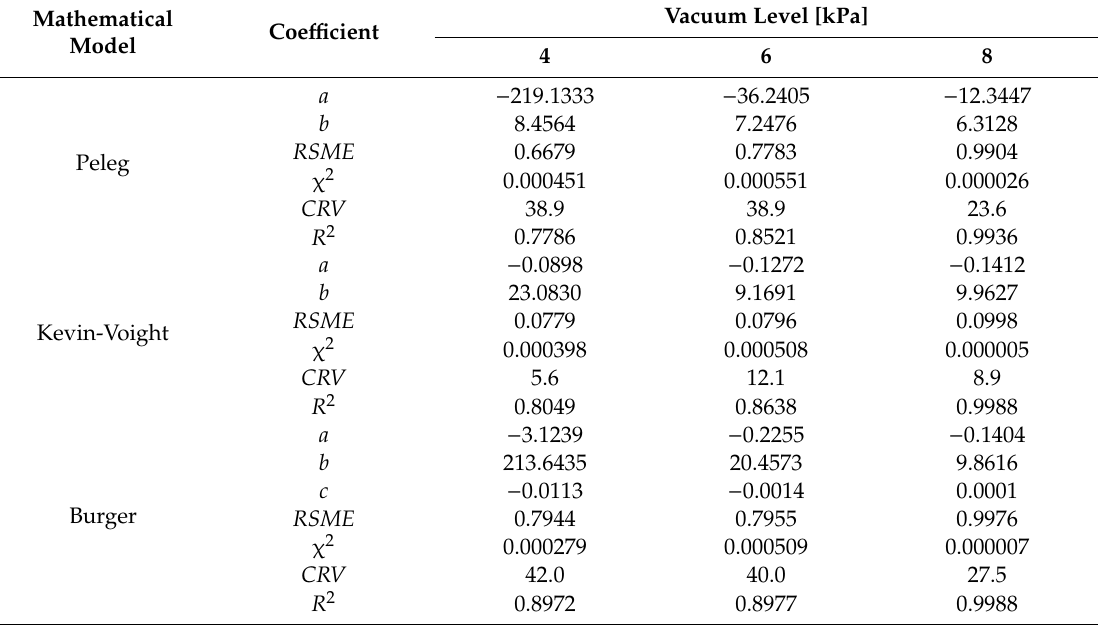
Table 3. Model coe ffi cients and statistical factors in mathematical models fitting the experimental data of solid gain (SG) changes during VI of apples at varied vacuum pressures of 4, 6, and 8 kPa using citric acid solution as the impregnating liquid.